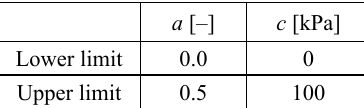
Table 2. The bound set of the